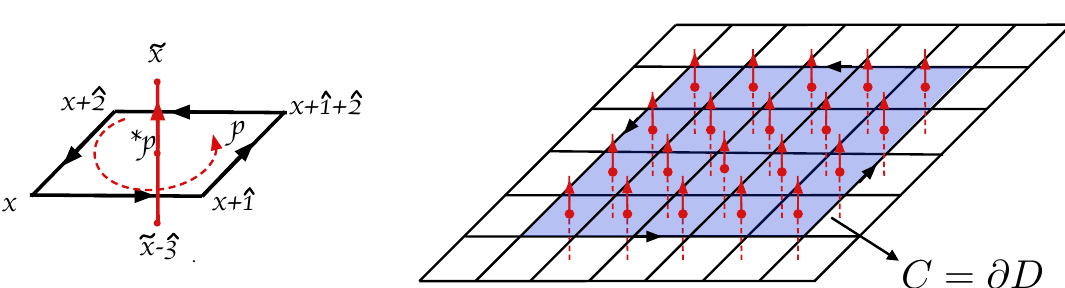
Figure 1 . Left: the dual of the plaquette p is the link ∗ p on the dual lattice intersecting p as shown. Right: D is the shaded region bounded by the curve C . The Poincare dual [ D ] is a bump 1-form on the dual lattice that is 1 on each of the red links shown, and 0 everywhere